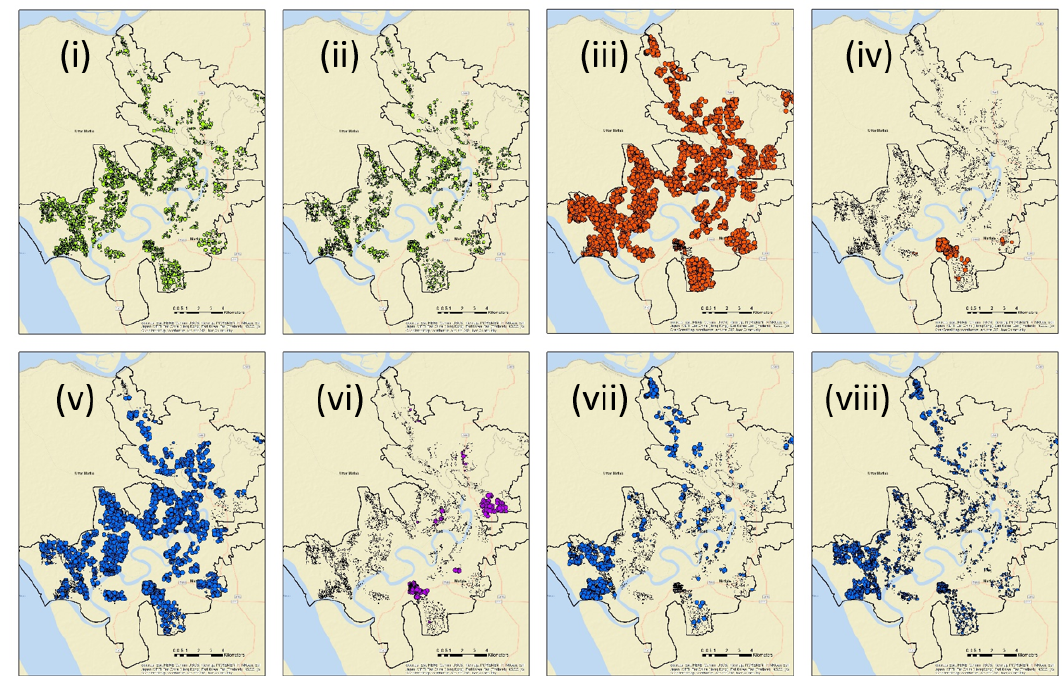
Figure 3. Selected variables from socio-economic survey data. Responses aggregated over bari.